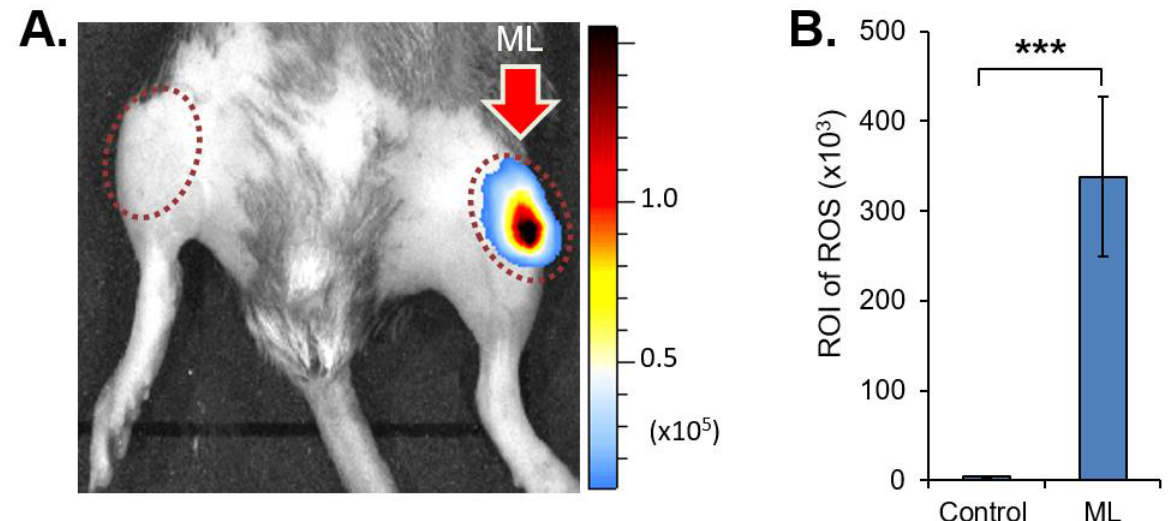
Figure 1. Comparison between mechanical loaded (ML) and unloaded knee joints for oxidative stress. ( A ) IVIS image showing the acute traumatic damage to knee joint following 1st mechanical load session. Observe high level of ROS-bioluminescence in the ML knee. ( B ) Graphical representation of ROS-bioluminescence in the region of interest (ROI). ROI graphed as radiant efficiency (photons/sec/cm 2 /sr)/( µ W/cm 2 ). Data are represented as mean ± SD. *** p < 0.001. ( n = 6 per group).